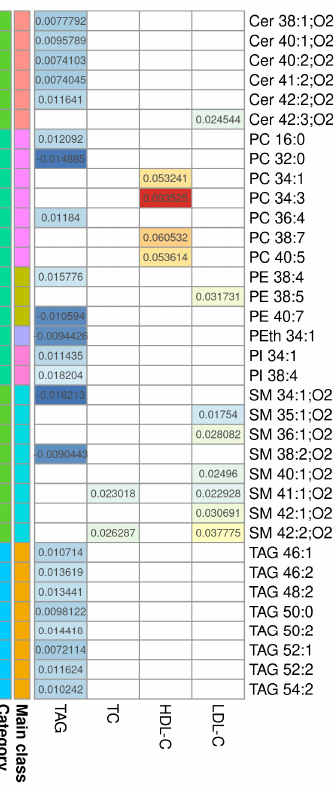
Figure 1. Heatmap of the regression coefficients for the models correlating with TAG, TC, HDL-C, and LDL-C. Heatmap of the coefficients for serum lipids obtained by each model and their MS- annotated lipids. Biochemically determined lipids are shown in columns and MS-annotated lipids are in rows. The colored bars represent the category and main lipid classes, as shown in the legend. GL: glycerolipids; GP: glycerophospholipids; SP: sphingolipids, Cer: ceramide; PC: phosphatidyl- choline; PE: phosphatidylethanolamine; PI: phosphatidylinositol; PS: phosphatidylserine; SM: sphingomyelin; TAG: triacylglycerol; TC: total cholesterol; HDL-C: high-density lipoprotein-choles- terol; LDL-C: low-density lipoprotein-cholesterol.